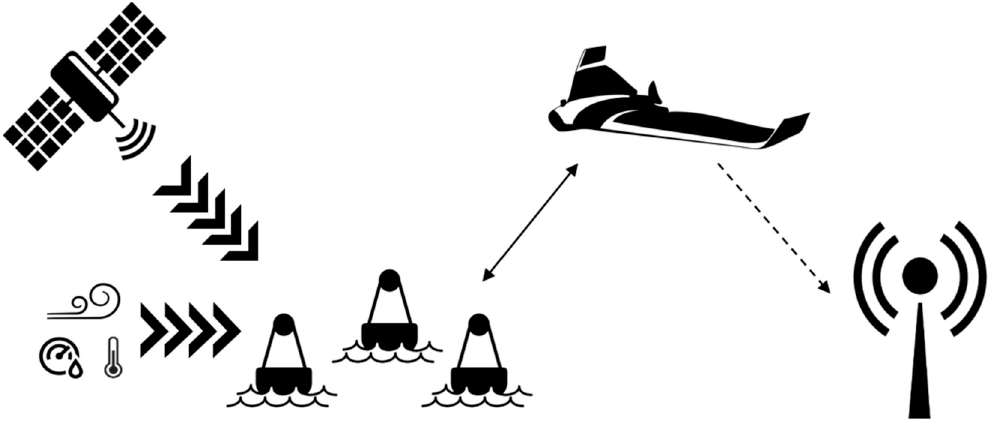
Figure 1. System interaction amongst the different devices of the network. The straight-line arrow indicates the main data transmission flow, the dashed arrow represents the communications with the optional ground station and the others indicate the environmental input to the buoys.